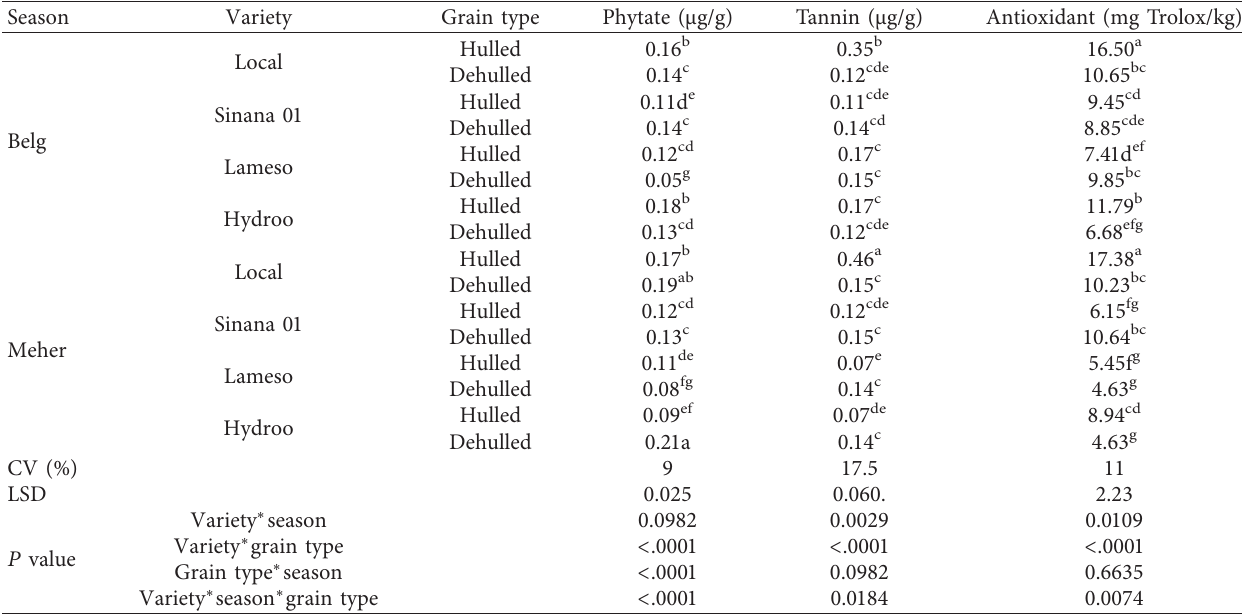
Table 7: Antinutritional factors (phytate and tannin) and antioxidant properties of emmer wheat affected by variety, growing season, and grain